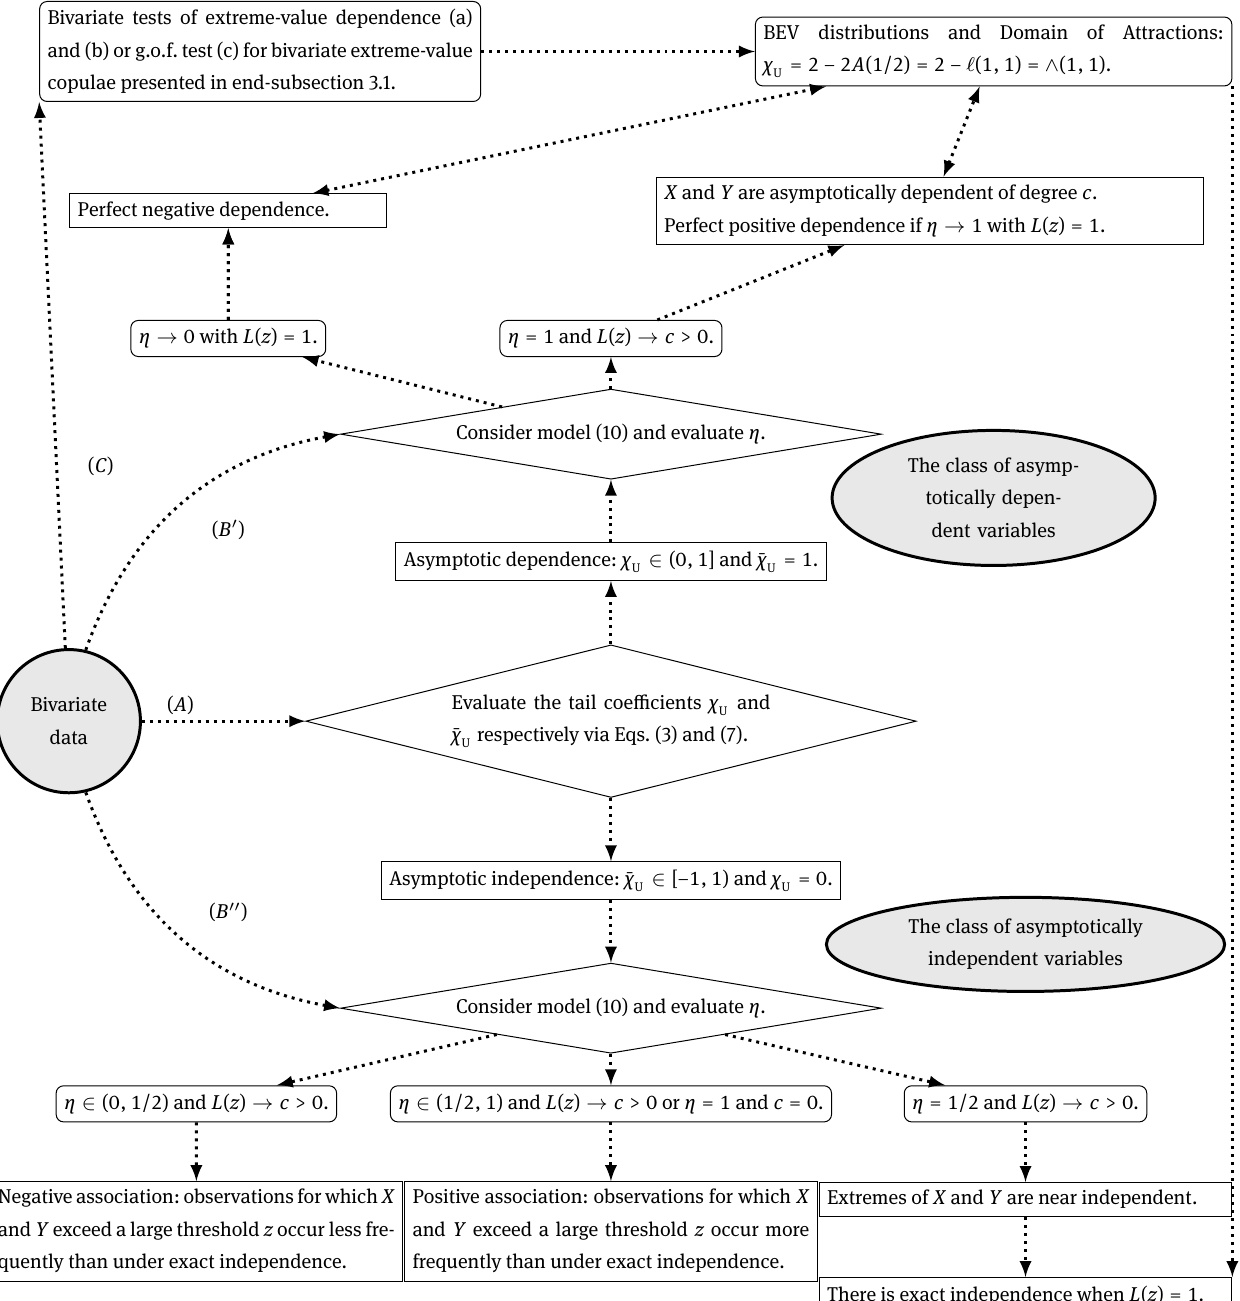
Figure 2: Diagram of the study of the tail dependence in bivariate frequency analysis. The circle denotes the starting point. We can follow the path ( A ) , ( B (cid:48) ) , ( B (cid:48)(cid:48) ) or ( C ) , however we recommend to follow the path ( A ) .